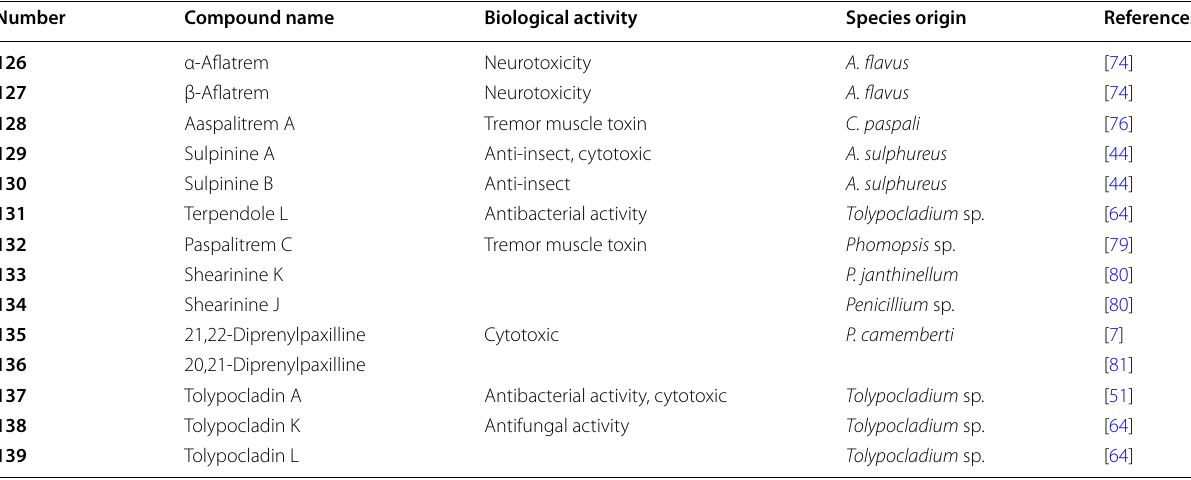
Table 9 Name, bioactivities and source of compounds with A‑ring